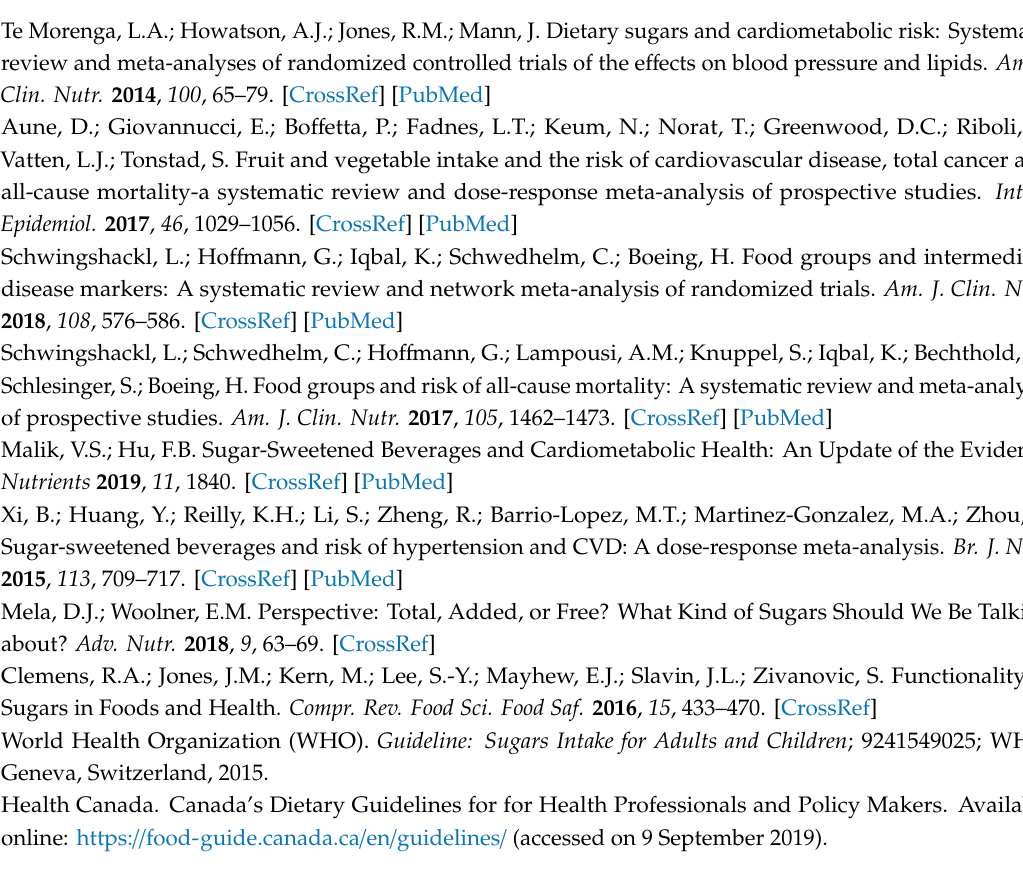
Table S1: Unadjusted mean intakes of total, free, and naturally occurring sugars, expressed in grams; percentage of total sugars; and percentage of energy they provide, in a representative sample of French-speaking adults of the Province of Qu é bec,